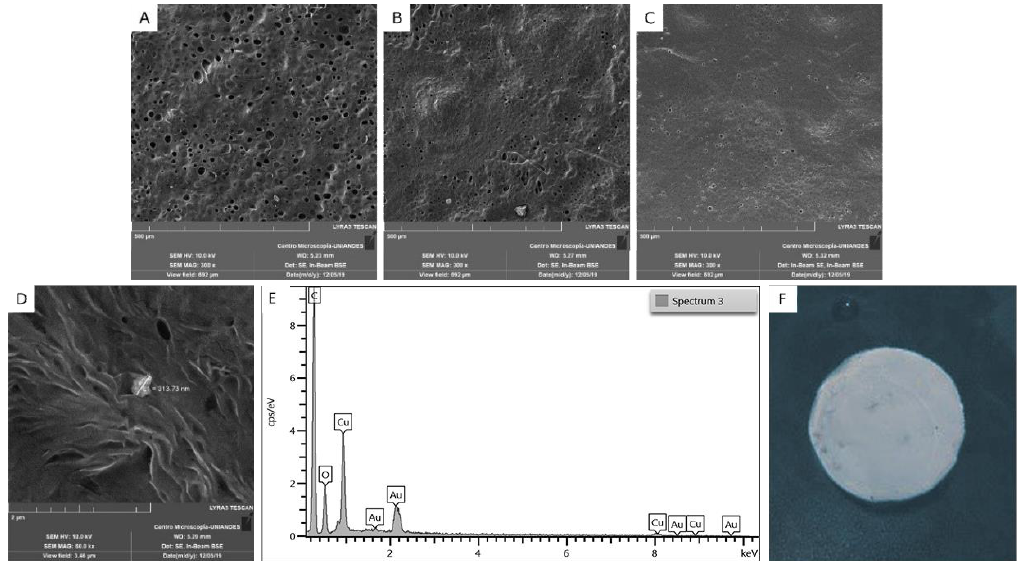
Figure 3. SEM micrograph of PCL films with copper oxide nanoparticles ( A ): PCL, ( B ): PCL + 0.1% CuONPs, ( C ): PCL + 0.07% CuONPs, ( D ): zoom-in image B, ( E ): EDS spectra for zoom-in image B, ( F ): Macroscopic aspect of PCL + 0.1% CuONP films.